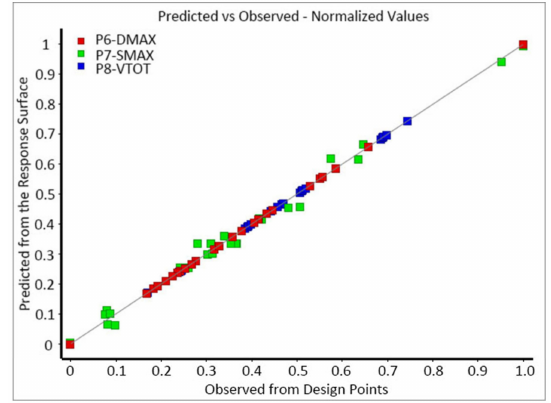
Figure 7. Goodness of fit of the model.